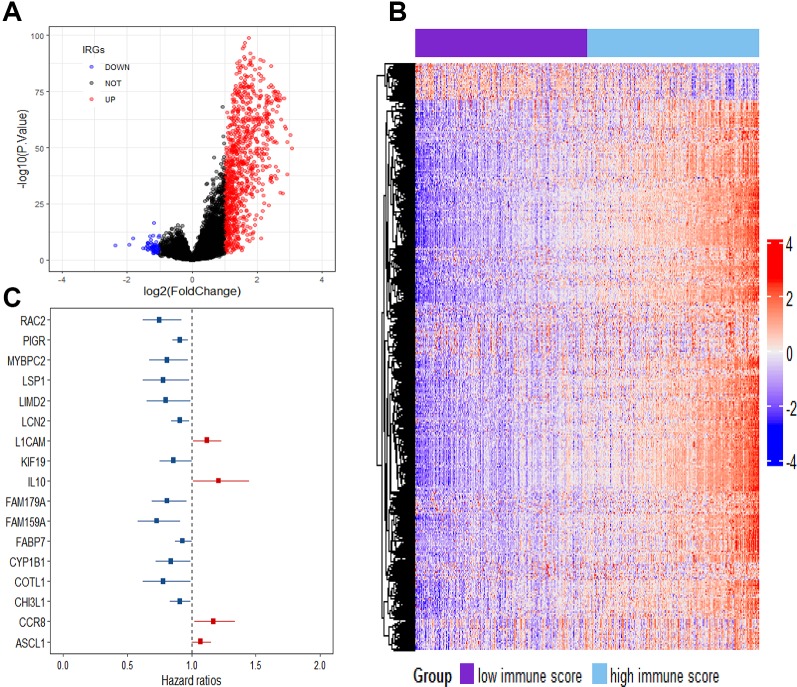
Comparison of gene expression profile with immune scores in breast cancer. (A) Volcano plot visualizing the immune-related genes between high and low immune score groups. Red plots represent aberrantly expressed genes with adjusted P-value < 0.01 and log2FC > 1. Black plots represent normally expressed genes. Blue plots represent aberrantly expressed genes with adjusted P value < 0.01 and log2FC < 1. (B) Heatmap analysis of the immune-related genes between high and low immune score groups. (C) Forest plot of hazard ratios showing the survival-associated immune-related genes.